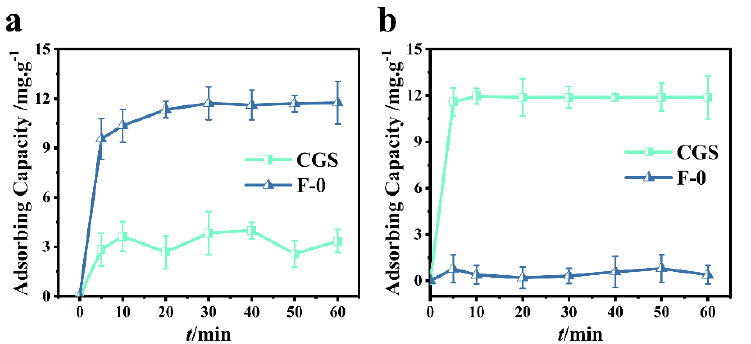
Figure 2. ( a ) Cr (VI) adsorption over CGS and F-0. Reaction conditions: Cr (VI) (40 mg/L, 60 mL), adsorbent (0.2 g). ( b ) RhB adsorption over CGS and F-0. Reaction conditions: RhB (40 mg/L, 60 mL), adsorbent (0.2 g).